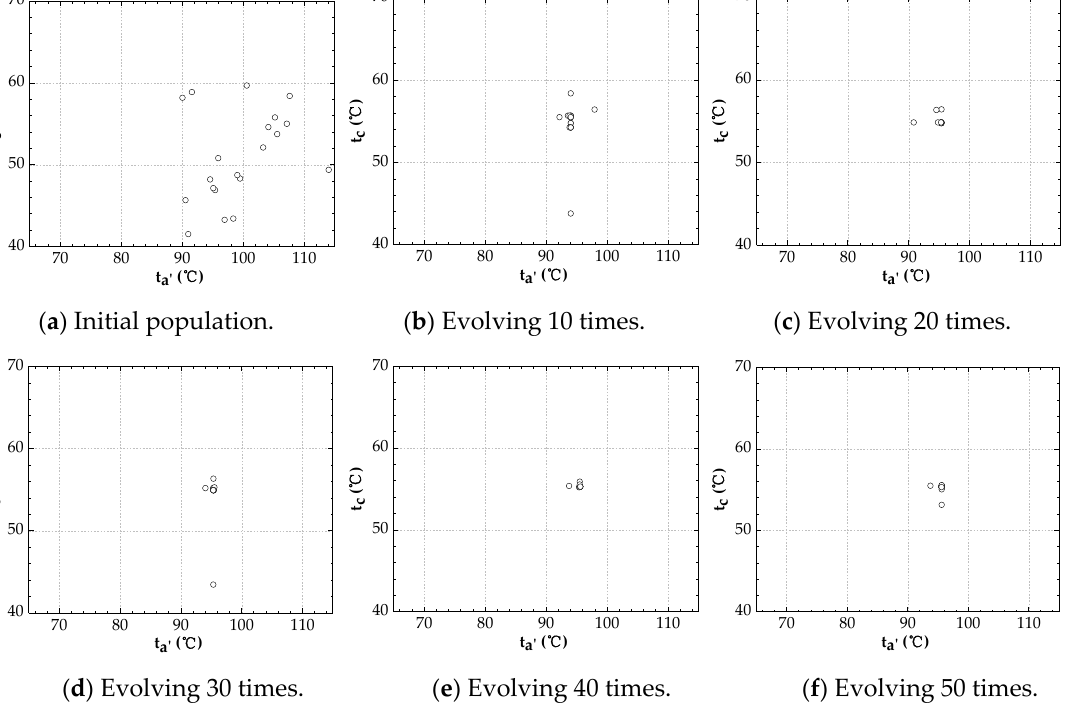
Figure 8. The distribution of 20 individuals in 50 evolution times.